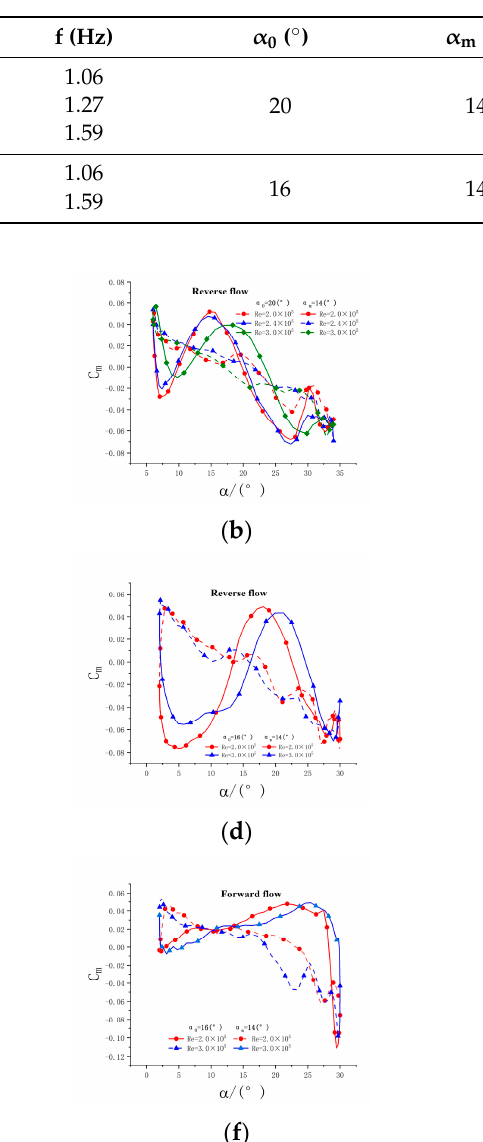
Table 11. Experimental conditions for changing the Reynolds numbers.